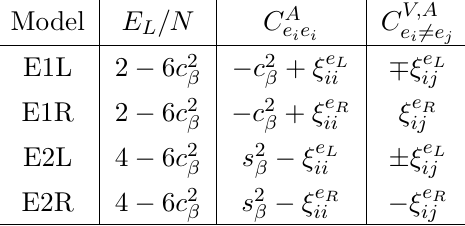
Table 2 . Axion couplings in the four models EL1, E1R, E2L, E2R, see eq. (2.10), as a function of the parameters ξ e P and c β ≡ cos β, s β ≡ sin β . Here E L denotes the contribution of the charged ij lepton sector to the electromagnetic anomaly coefficient E , to be added to the contribution from the quark